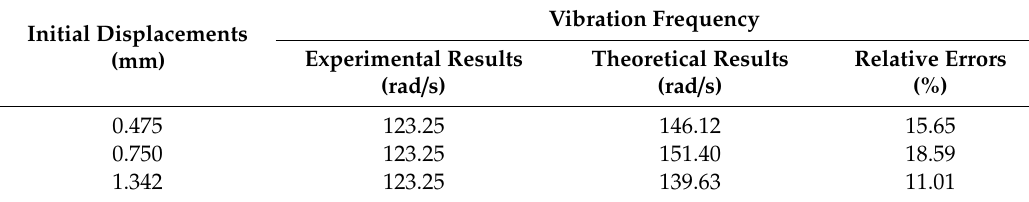
Table 2. Frequency comparison of the experimental results and theoretical results.